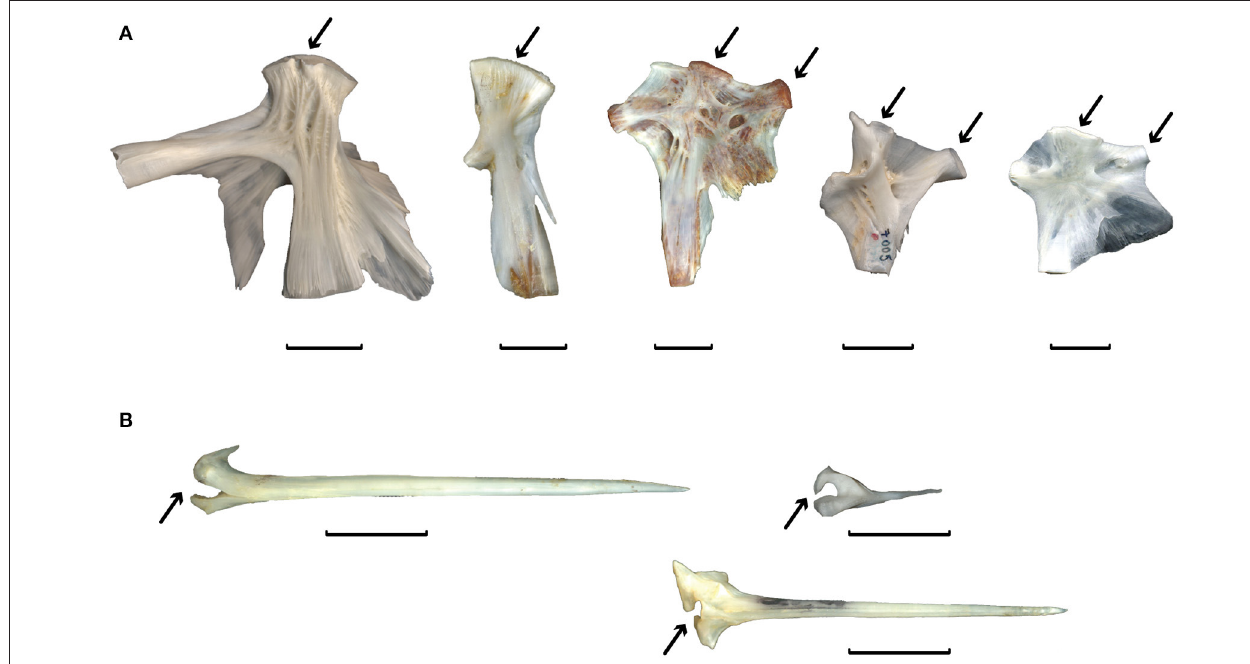
FIGURE 9 | Examples of synapomorphies of Clade A. (A) Left hyomandibulae in medial view (anterior faces right) of (from left to right) Gadus morhua , PB-A-16; Zeus faber , MNHN uncataloged; Dicentrarchus labrax , MNHN uncataloged; Batrachoides pacifici , PB-7005; Brotula clarkae , PB-6515. Arrows point to the head(s) of the cranio-hyomandibular articulation. (B) Left pelvic-fin spines in anterior view of (from left to right and top to bottom) Zeus faber , MNHN uncataloged; Batrachoides pacifici , PB-7005; Dicentrarchus labrax , MNHN uncataloged. Arrows point to the base of the pelvic spine. Scale bar equals 10 mm. Photos D. Davesne and Osteobase